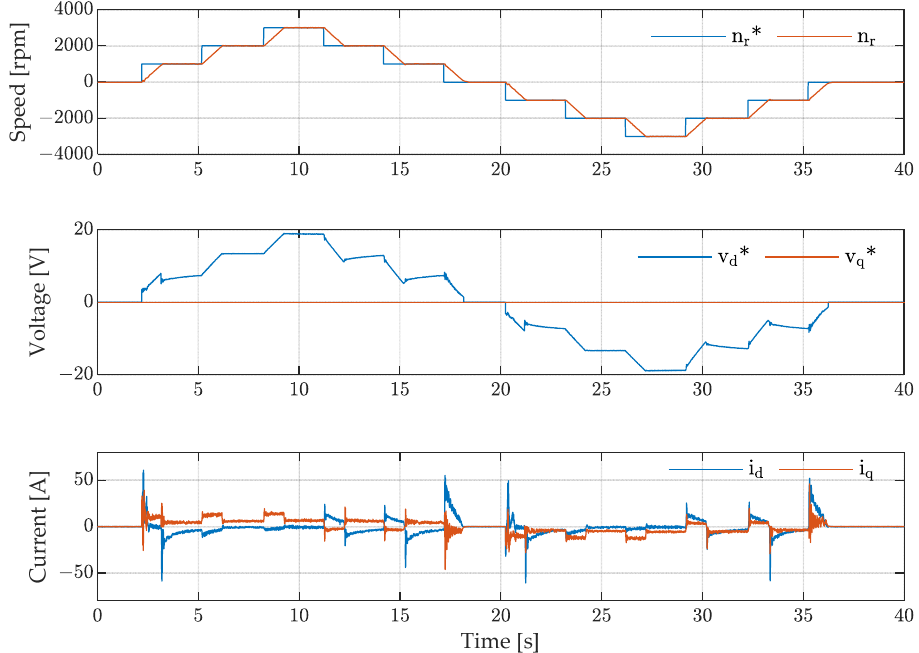
Figure 25. Speed profile up to nominal reference speed with no ‐ load and required power factor of 1: speed, dq voltages, dq currents.